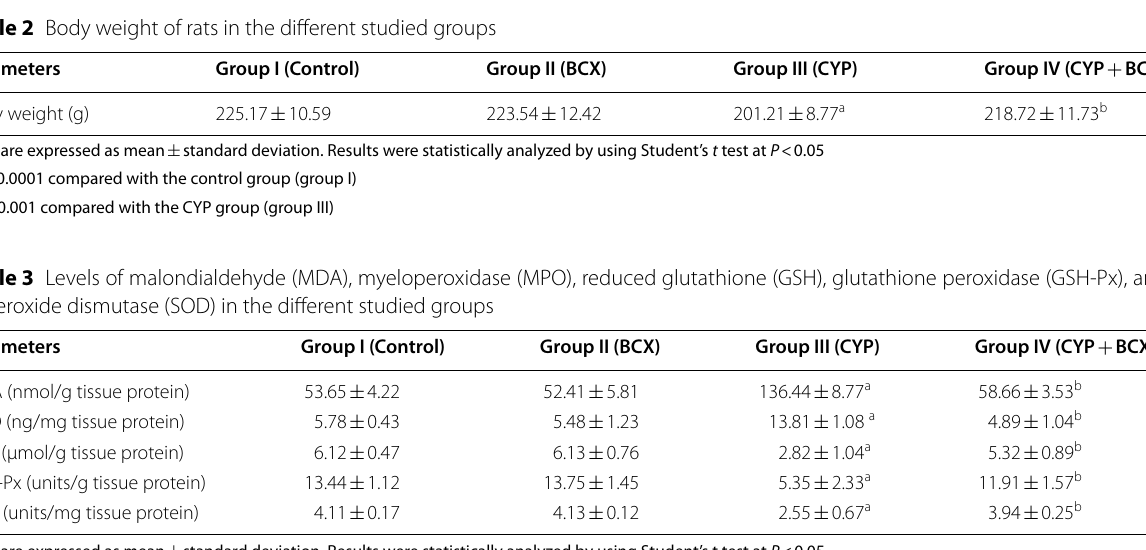
Data are expressed as mean standard deviation. Results were statistically analyzed by using Student’s t test at P < 0.05 ± a P < 0.0001 compared with the control group (group I) b P < 0.0001 compared with the CYP group (group III)